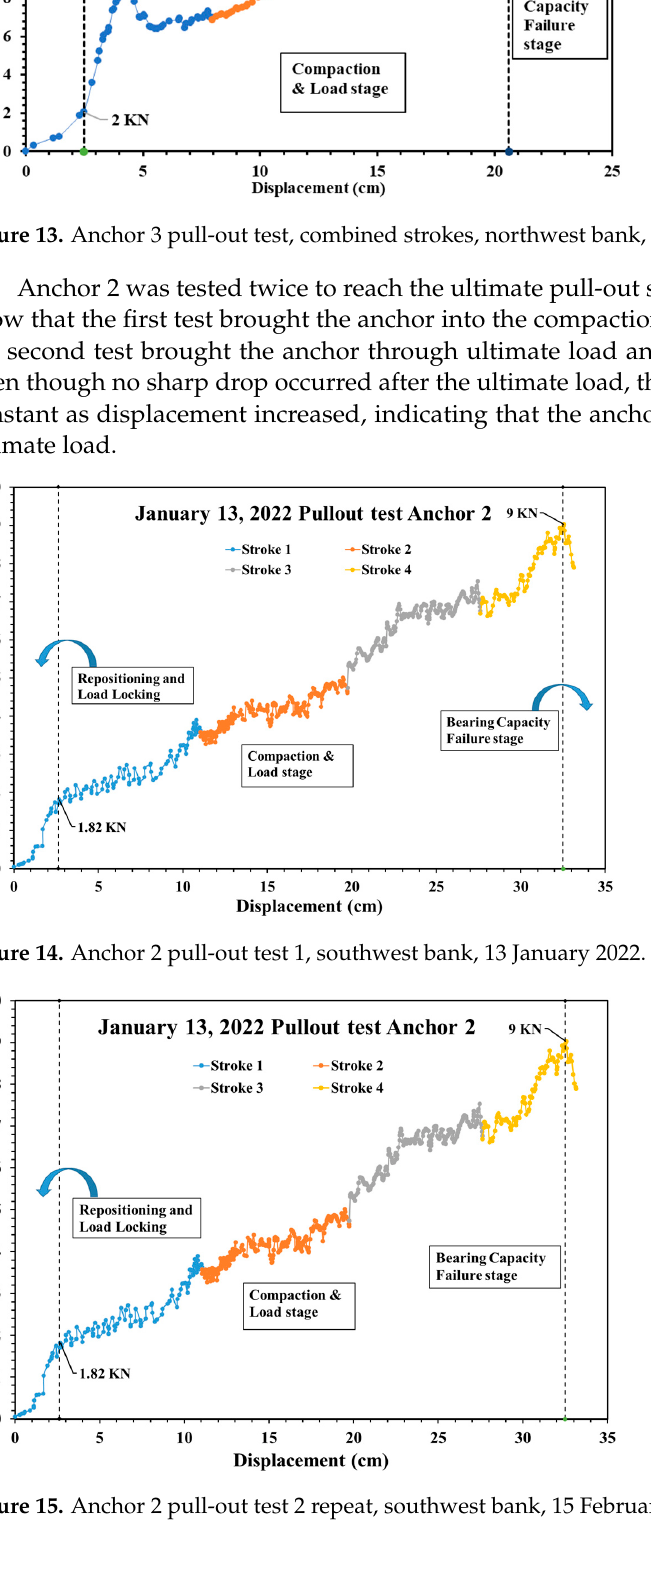
Figure 12. Schematics of field anchor pull-out test. Anchor 3 pull-out test, all strokes, northwest bank, 25 January 2022.